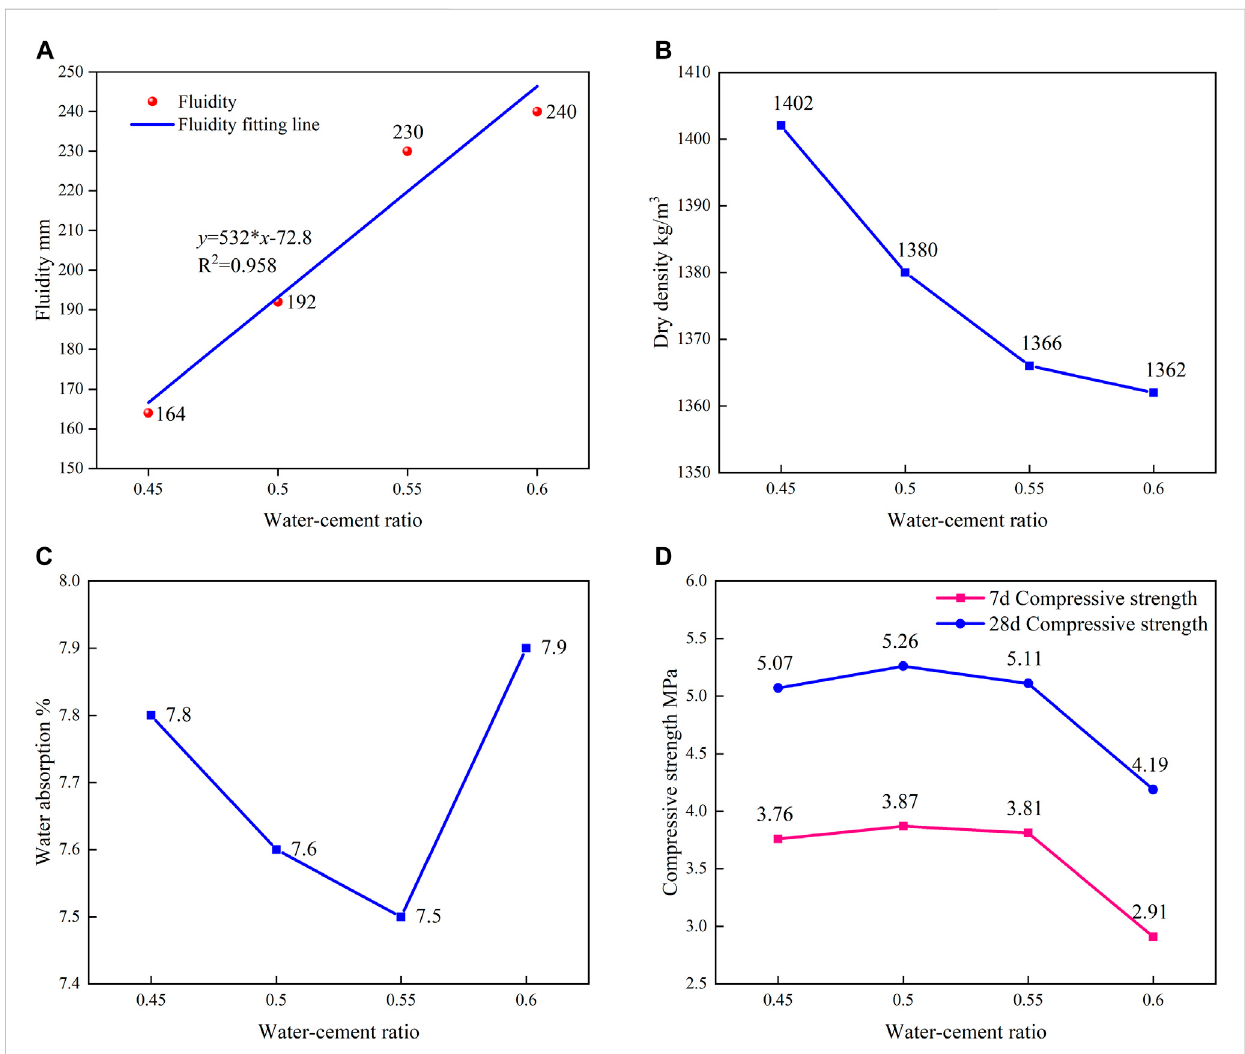
FIGURE 7 The in fl uence of water-cement ratio on sample performances: (A) fl uidity; (B) dry density; (C) water absorption; (D) compressive strength.